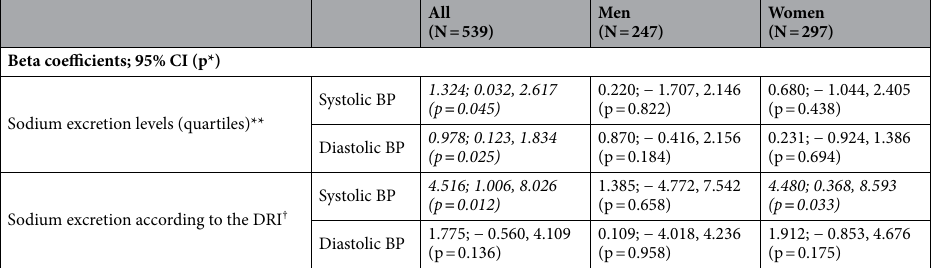
Table 4. Prediction of measured blood pressure by sodium excretion levels (as quartiles or according to DRI upper-level recommendations) adjusted for other explanatory variables and stratified according to sex—results from a multivariate linear regression. *Significant beta coefficient value is considered as p < 0.05 and wrriten in italics **Q1 (up to 2645); Q2 (2645.1–3541); Q3 (3542–4755.24); Q4 (> 4755.25). † Defined as 0 (below 2400 mg/day) or 1 (≥ 2400 mg/ day) – based on upper limit suggested by the DRI. Models adjusted to: diabetes presence (0 = no; 1 = yes), coronary heart disease presence (0 = no; 1 = yes), age, energy intake, smoking (0 = no or in the past; 1 = yes), ideal physical activity (As recommended by the American College of Sports Medicine [ACSM]-150 weekly minutes or more of moderate intensity or 75 weekly minutes of intense physical activity; 0 = no; 1 = yes) and BMI categories (1. up to 18.5 2. 18.5–24.99 3. 25–29.99 4. 30–34.99 5. above or equal 35). BP Blood Pressure, CI Confidence Interval, DRI Dietary Reference Intakes.